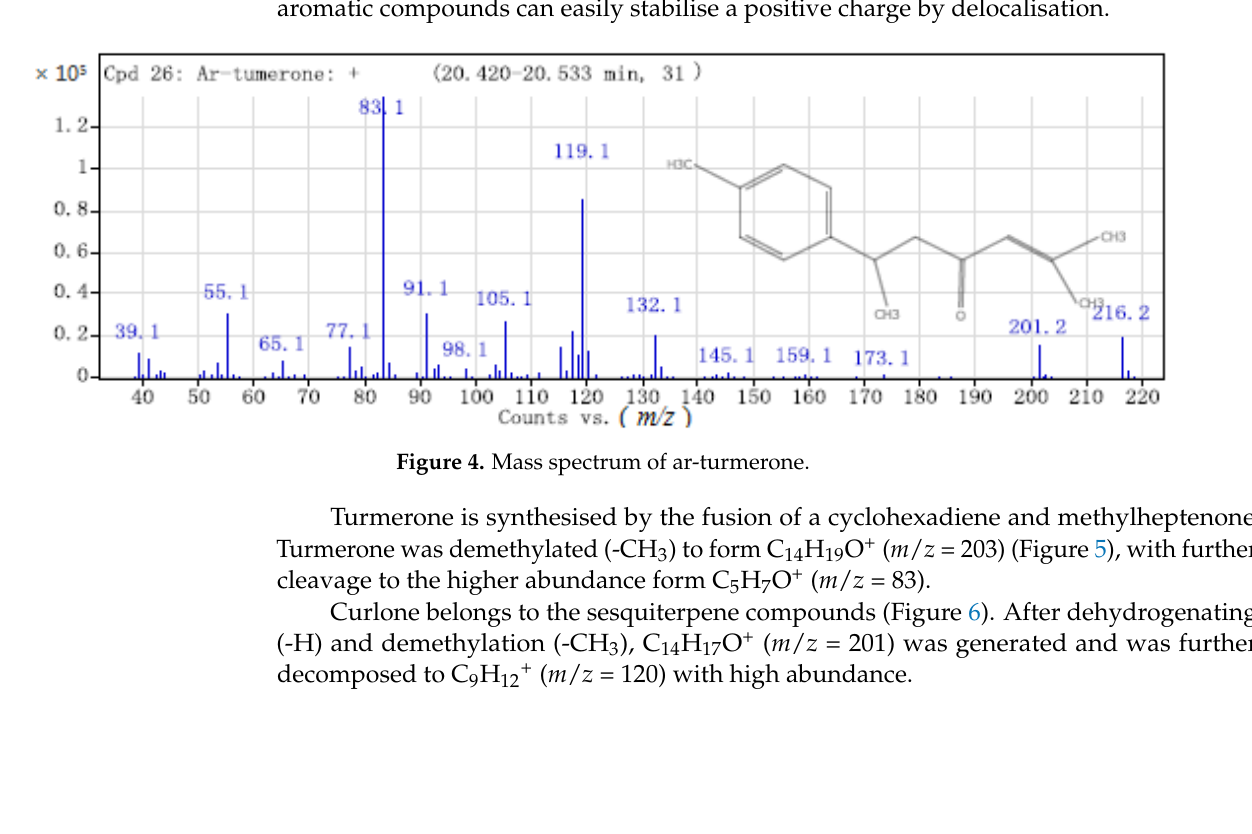
Figure 5. Mass spectrum of turmerone.